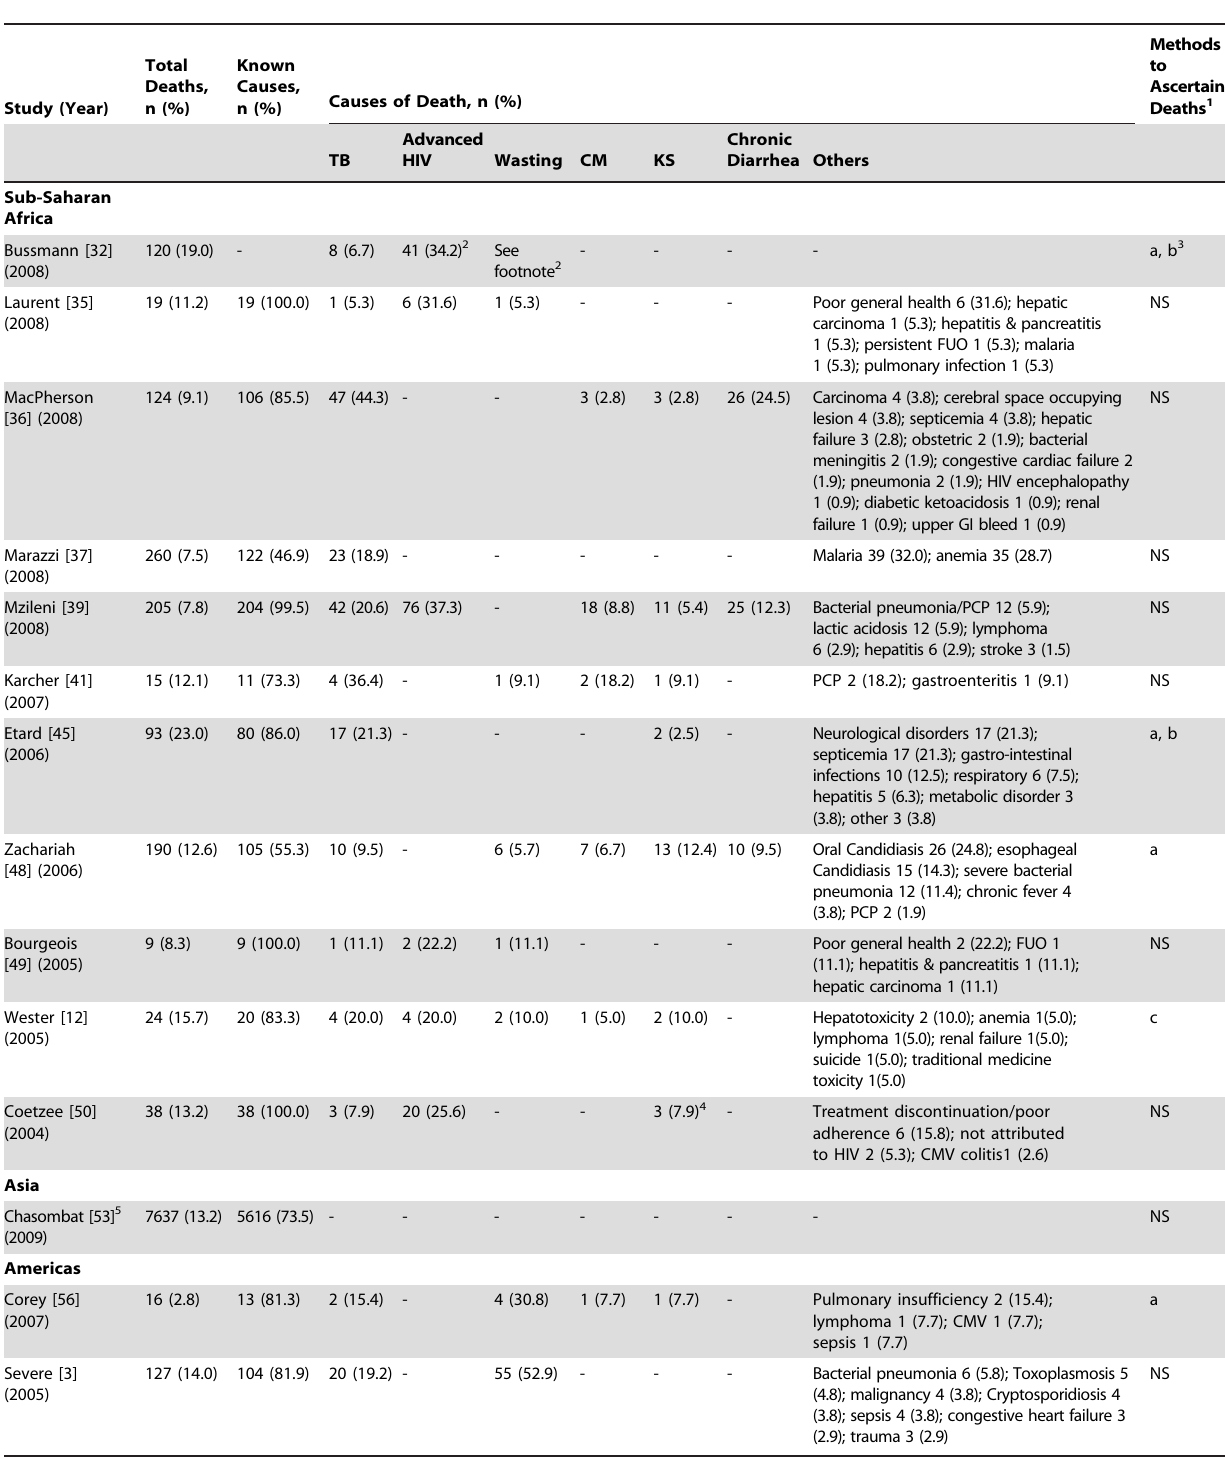
Table 3. Reported causes of death in included early mortality studies by